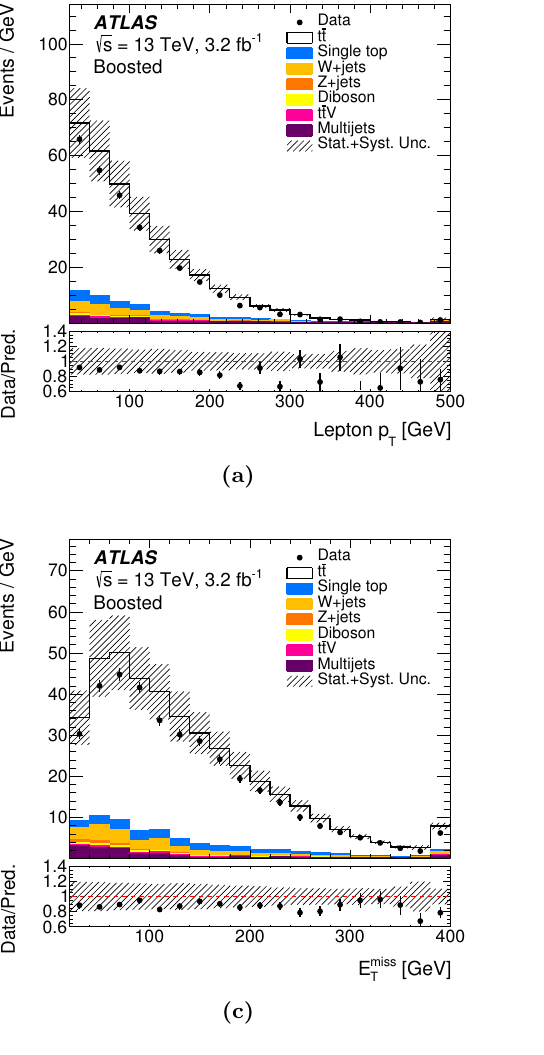
Figure 4. Kinematic distributions in the combined ‘ +jets channel in the boosted topology at detector level: (a) lepton p T and (b) pseudorapidity, the (c) missing transverse momentum E miss and (d) transverse mass of the W boson. Data distributions are compared to predictions using Powheg + Pythia6 as the t (cid:22) t signal model. The hatched area indicates the combined statistical and systematic uncertainties in the total prediction, excluding systematic uncertainties related to the modelling of the t (cid:22) t system. Events (below) beyond the range of the horizontal axis are included in the ((cid:12)rst) last